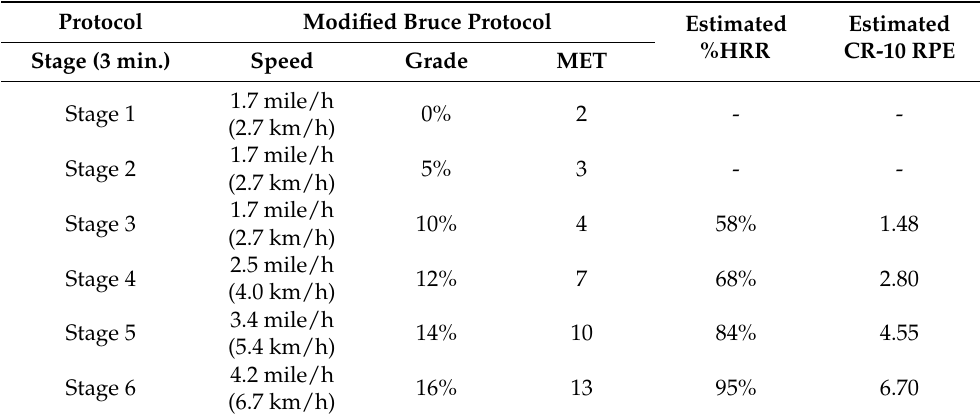
Table 3. Modified treadmill protocol for exercise stress testing for the proposed therapeutic exer- cise